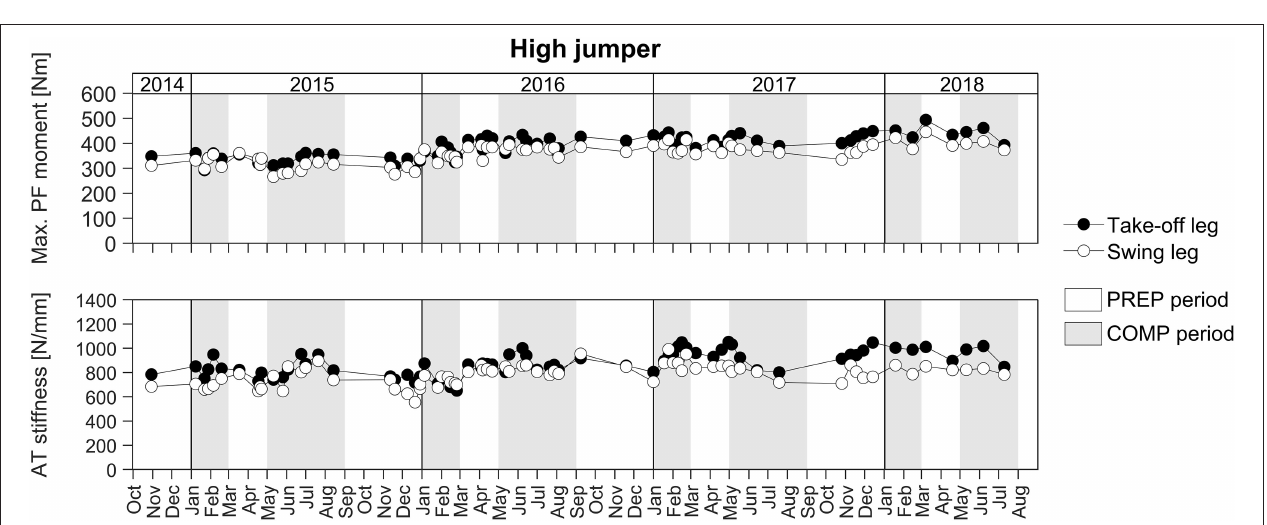
FIGURE 3 | Adaptive changes in TS muscle strength (Max. PF moment) and tendon stiffness (AT stiffness) in the take-off and swing leg of one elite high jumper over a period of 4 years of athletic training separated into preparation (PREP) and competition (COMP) periods.